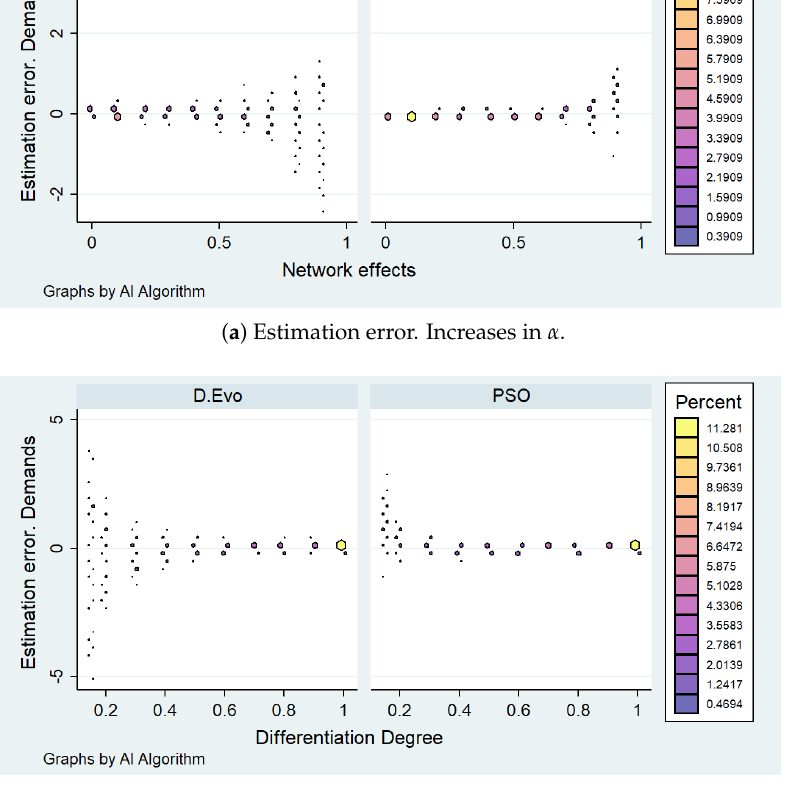
Figure 2. Demand estimation by parameter. Left = network effects; Right = differentiation. Source: